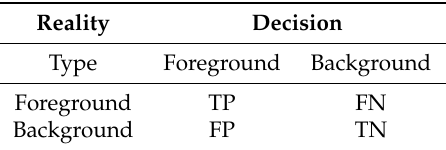
Table 1. Ranking of decisions.